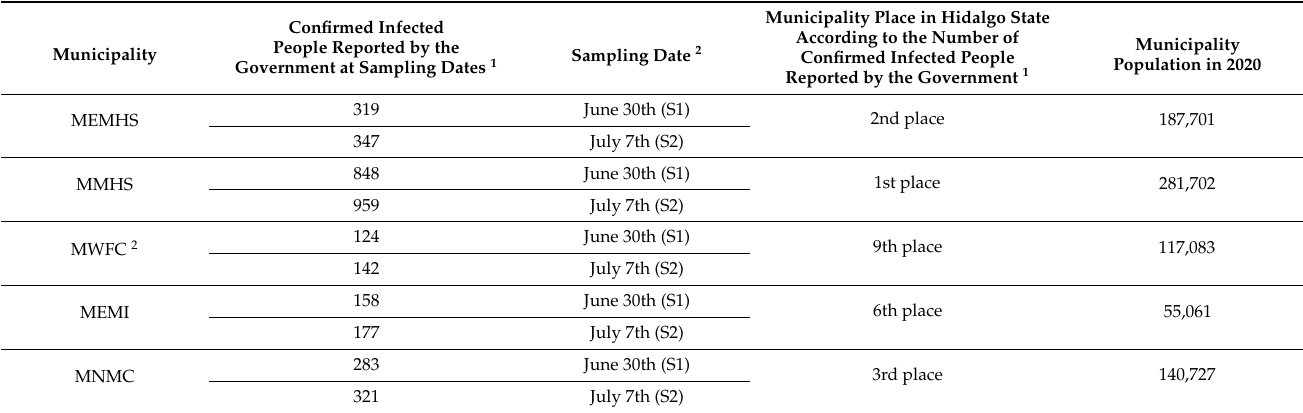
Table 1. COVID-19 cases in municipalities where the sampling sites are